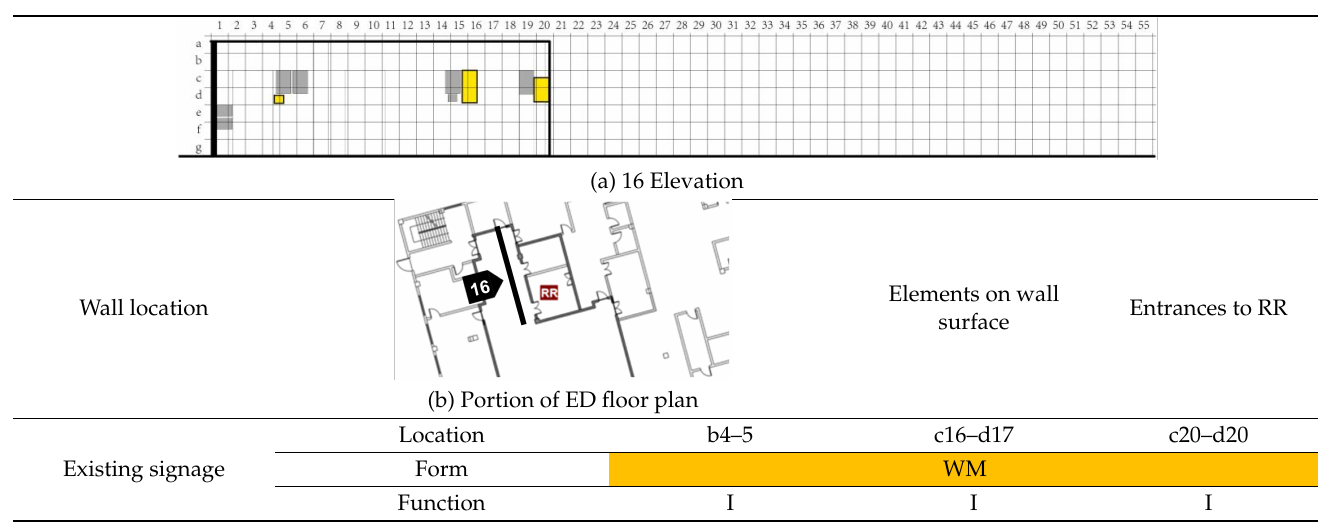
Table 20. 16 Elevation comparative analysis.